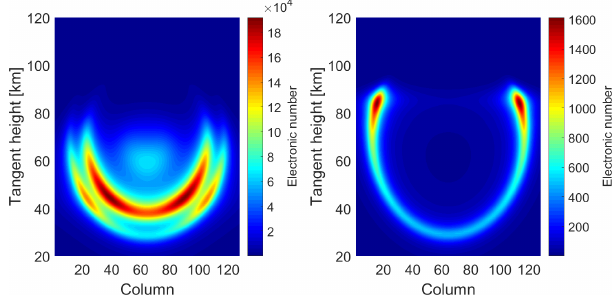
Figure 5. The simulated interferogram images of the weak O 2 ( a 1 (cid:49) g ) and OH emission